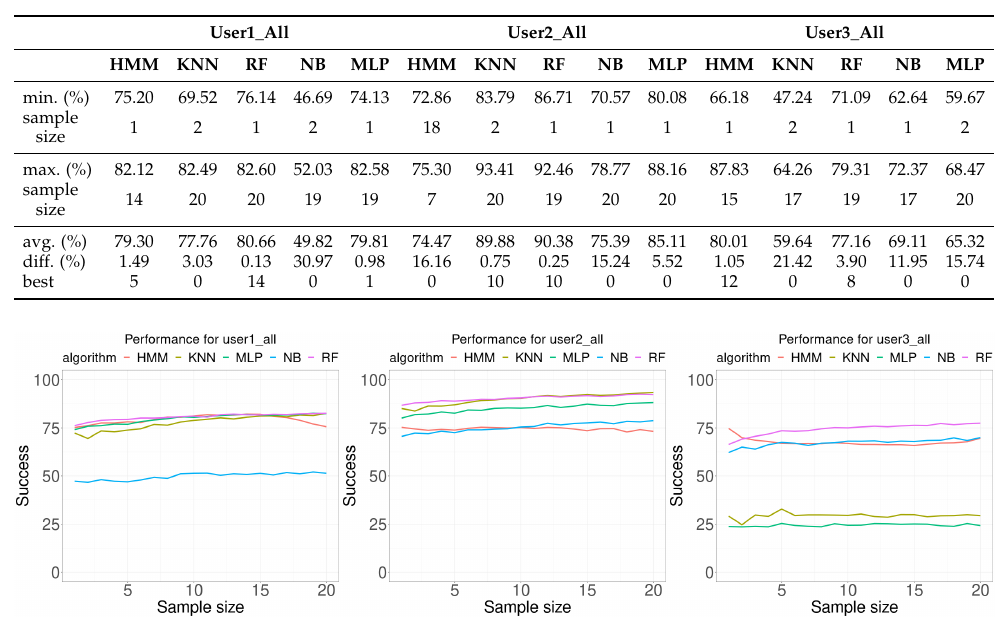
Table 6. Summary of the data shown in Figure 10. The rows for minimum (min.), maximum (max.), average (avg.), and difference (diff.) are given in percentages of successful classification experiments. The row labeled as size is for the corresponding sample size. The row labeled as #best is for the number of times the corresponding algorithm provided the best results.